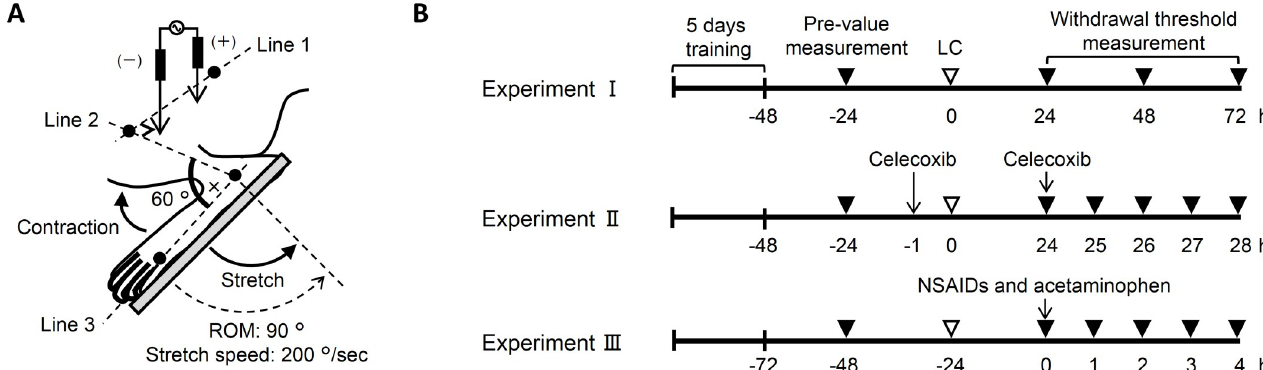
Fig 4. Lengthening contractions and experimental schedule. (A) Schematic illustration of the method for lengthening contractions (LC, modified from [10] with permission). LC was induced by electrical stimulation through a pair of needle electrodes, which were insulated except for the tips. A positive and negative electrode was inserted near the sciatic and peroneal nerve, respectively. Electronic currents were supplied via the needle electrodes to induce contraction of the ankle extensor muscles. In synchronization with contraction, the extensor muscles were stretched by rotating a foot plate, which was attached and fixed to the rat footpad. Stretch range of motion (ROM) was precisely defined based on three axes (see Methods for details). LC was performed with a ROM of 90˚ and angular velocity of 200˚/s for a total of 50 repetitions. (B) Time schedule for Experiment I–III. Following training sessions for 5 days, pre-value was measured 24 h prior to LC. Measurements were repeatedly performed to determine the time course of muscular mechanical hyperalgesia (Experiment I), to examine analgesic effect of celecoxib (Experiment II), and to examine the efficacy of NSAIDs and acetaminophen (Experiment III). Open arrowhead: time point of LC, closed arrowheads: time points of threshold measurement, and arrows: time points of oral administration of